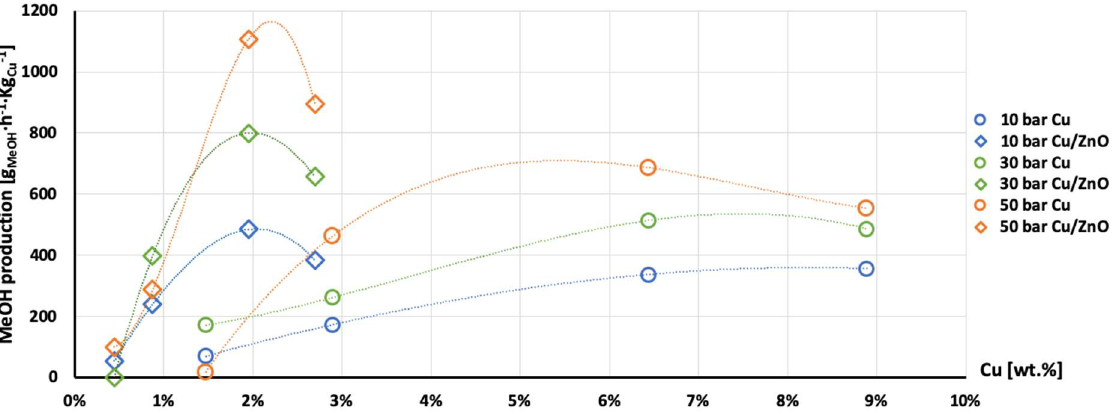
Figure 10. Production of DME per gram of Cu for AlNFs-Cu and AlNFs-1Cu2.3Zn catalysts at pressures of 10, 30, and 50 bar and temperatures of 225, 250, 275, and 300 °C.